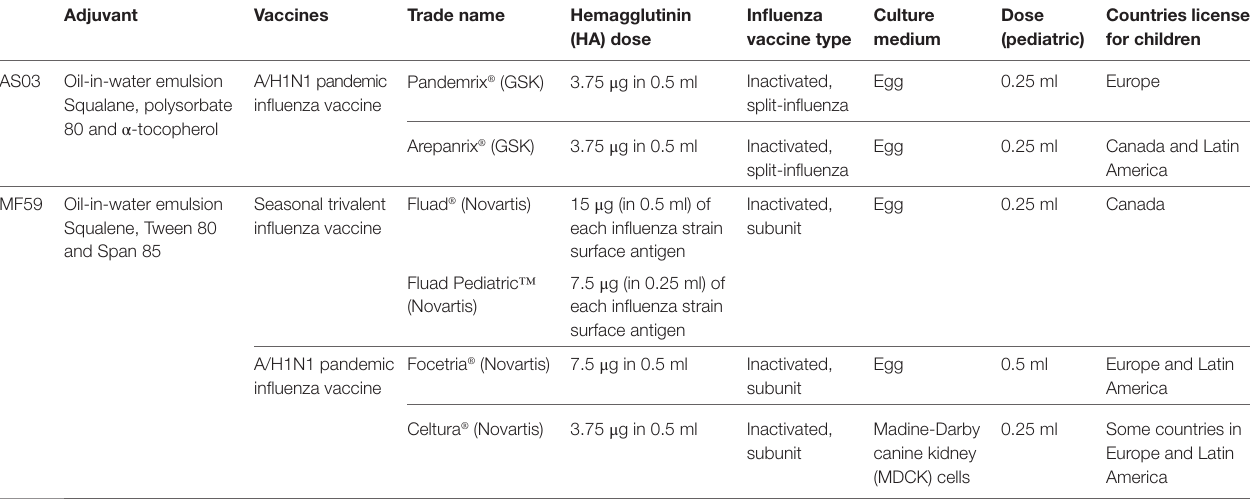
TAbLe 1 | AS03- and MF59-adjuvanted vaccines for